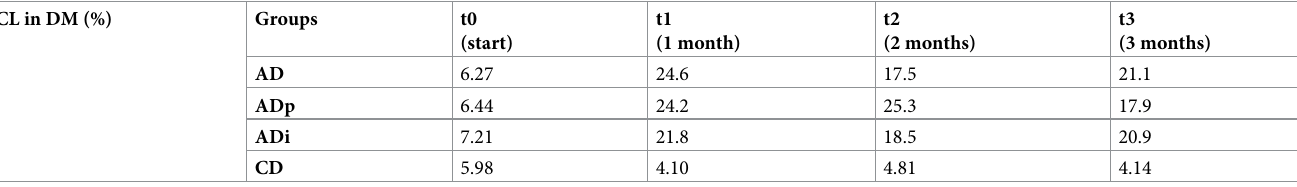
Data are presented as percentages (in DM) for one pool of ten animals per group. CL, crude lipid; DM, dry matter; AD, group fed an atherogenic diet (n = 10);